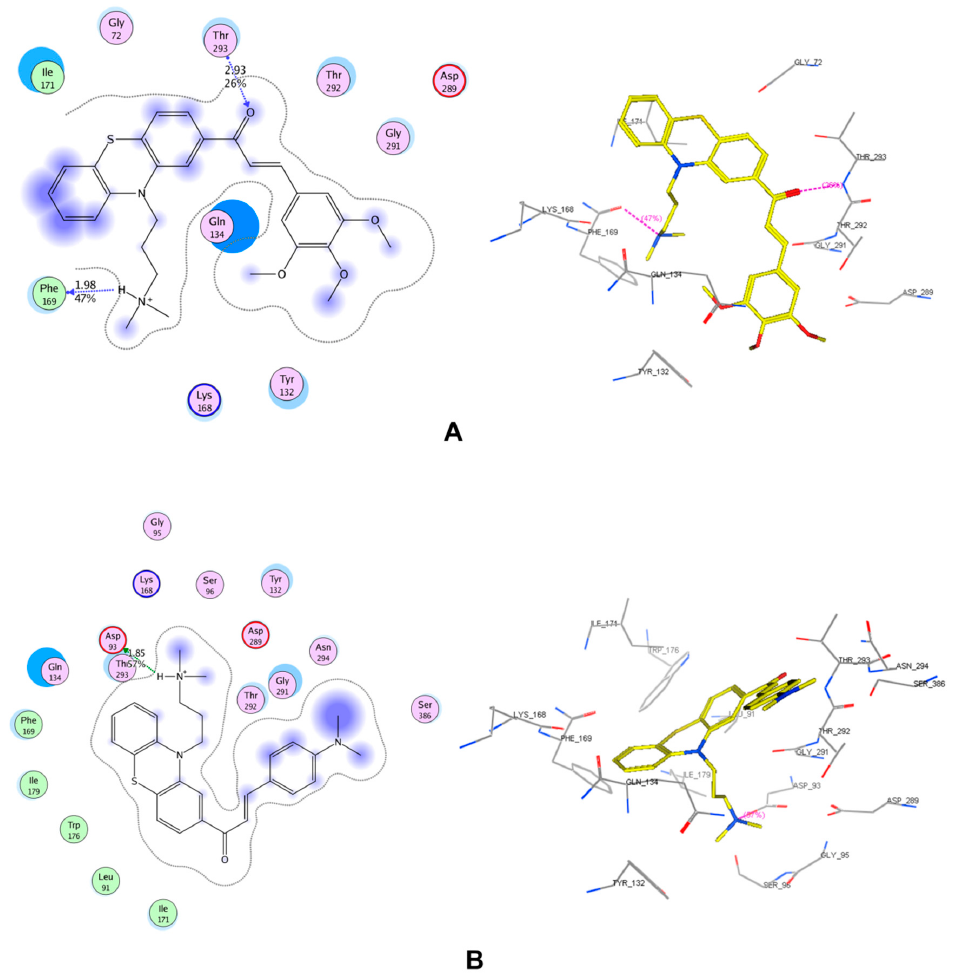
Figure 3. Interactions in the binding pocket of beta-secretase (BACE-1, complex 5HU1-chain A) made by ( A ) AC4 (observed pIC 50 : 6.81 ± 0.09), ( B ) AC12 (observed pIC 50 : 6.46 ± 0.05).